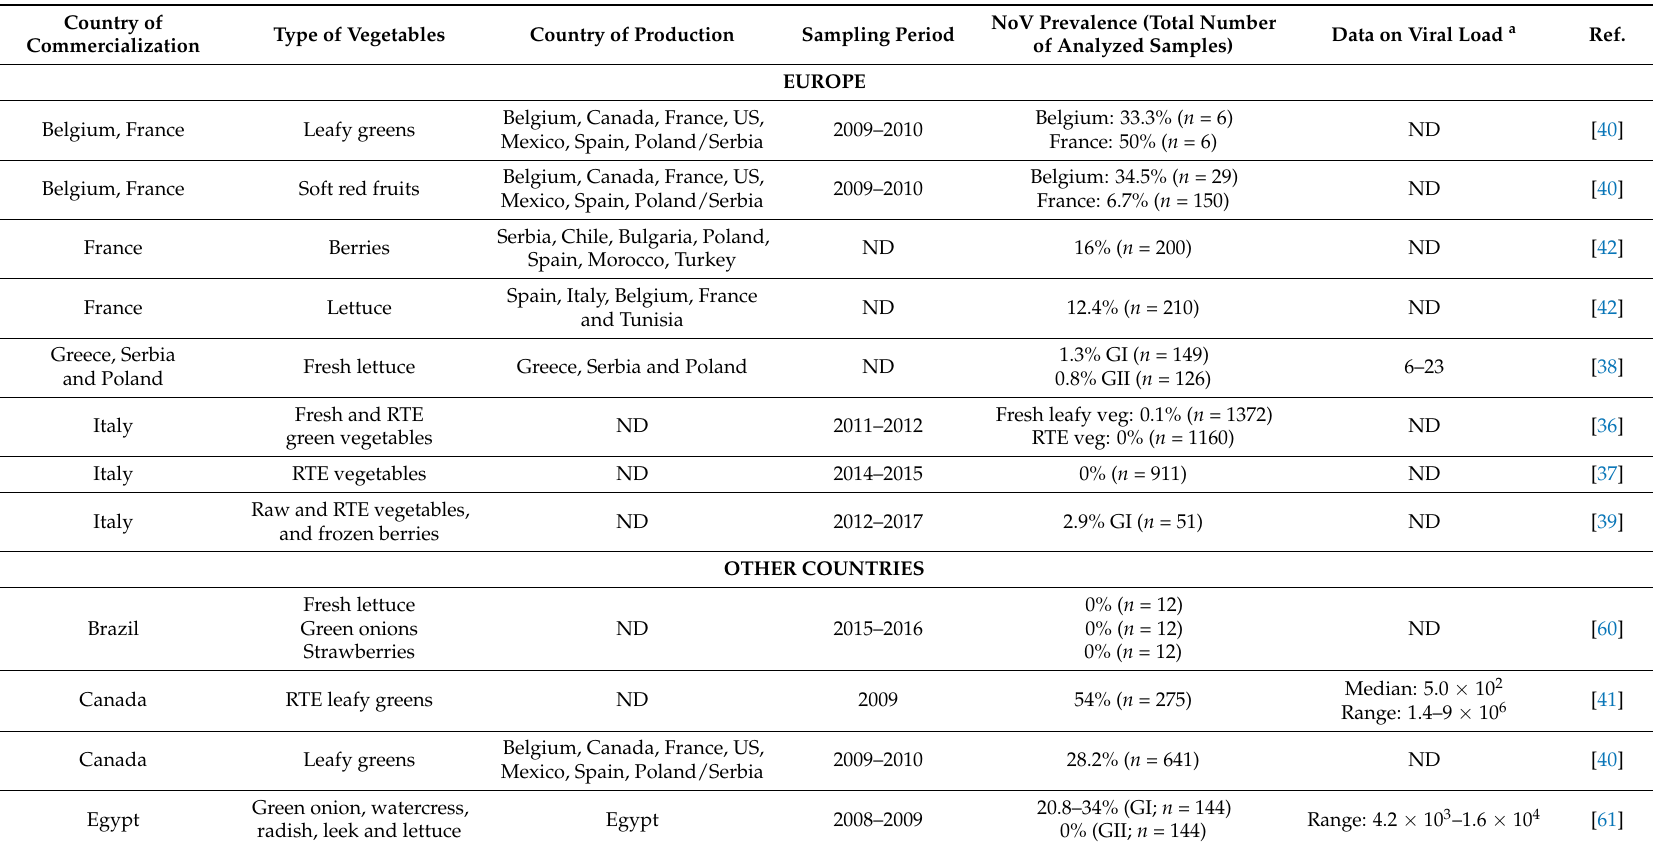
Table 2. Prevalence studies of norovirus (NoV) in fruits and